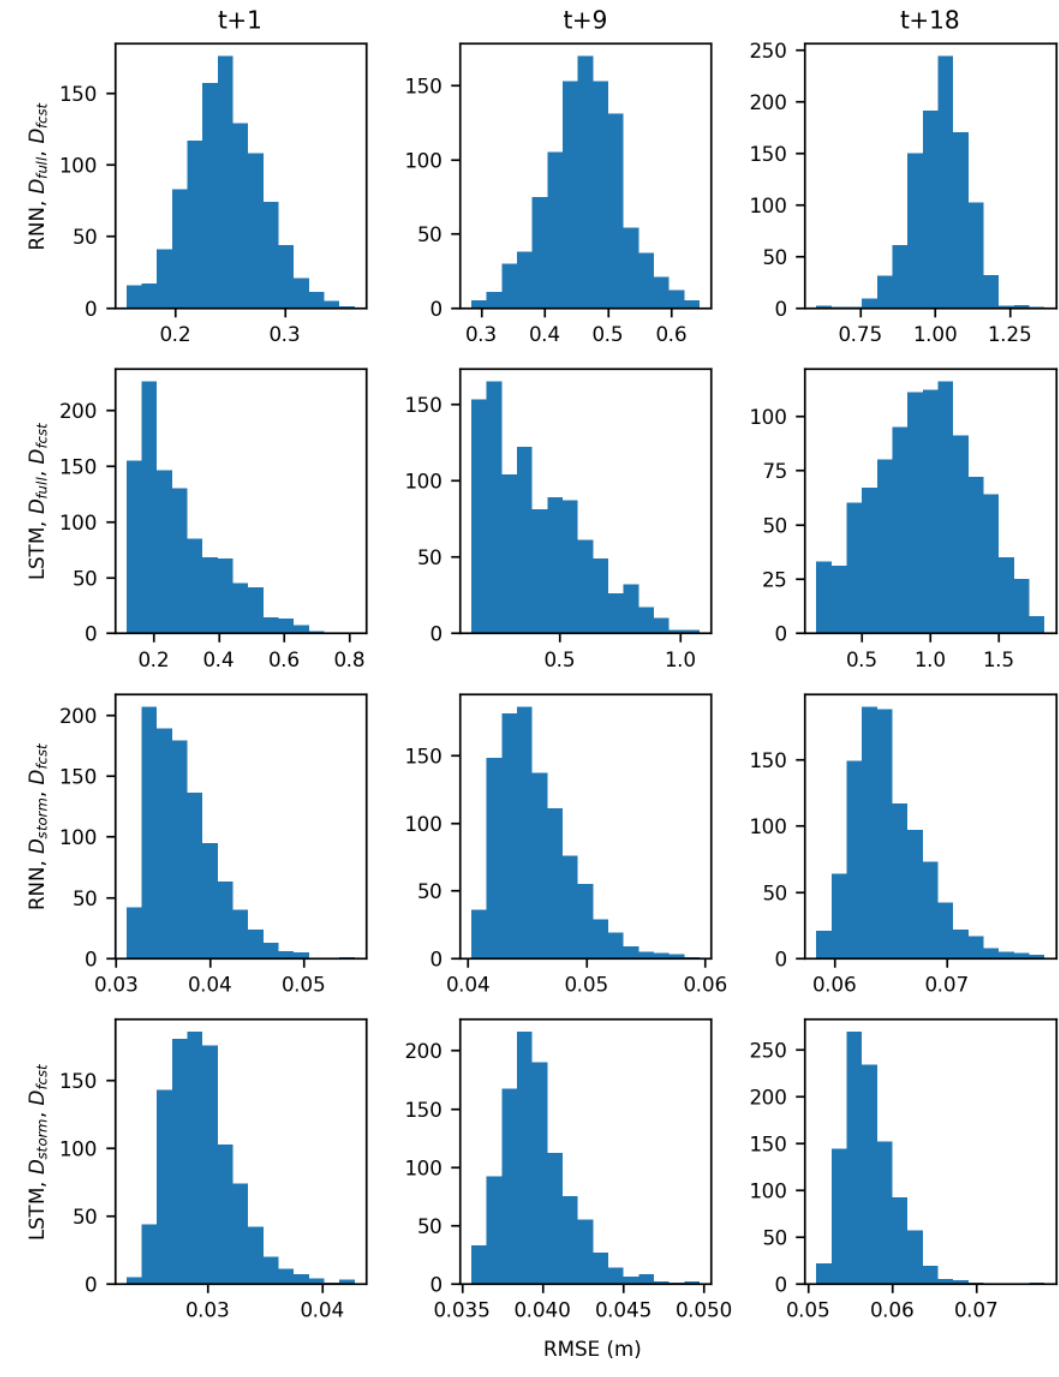
Figure A8. RMSE distributions for GW1 using forecast input data. Columns represent the forecast horizons t + 1, t + 9, and t + 18. Rows are specified as model type, training data, and testing data.